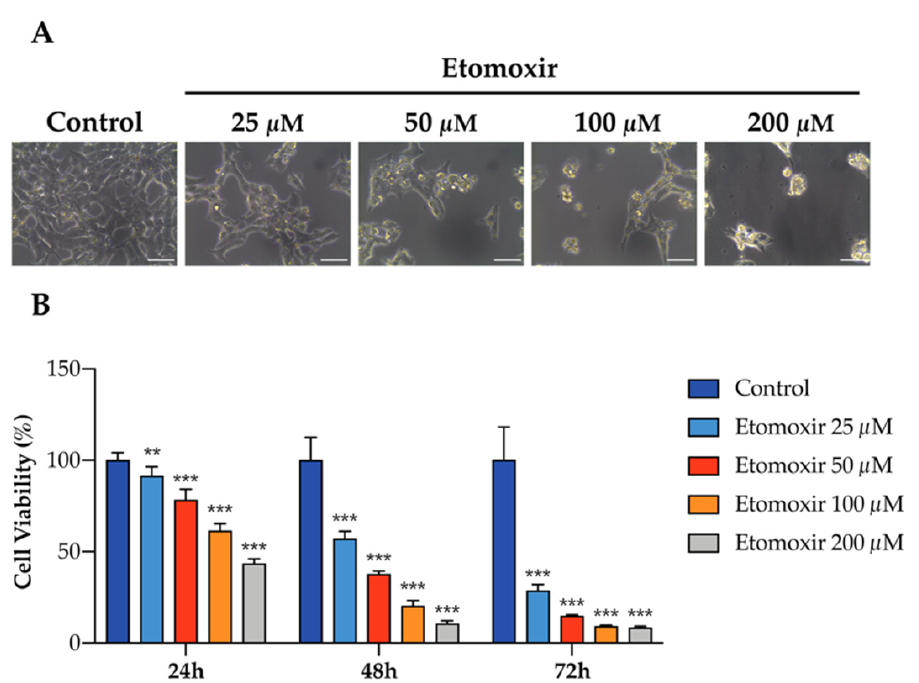
Figure 3. Inhibition of fatty acid oxidation induces cell death in human HAC15 cells. ( A ) Represen- tative images of the effects of etomoxir in HAC15 cells in 6-well plate for 72 h. Scale Bar: 50 µ m. ( B ) Cell viability in HAC15 cells treated with increasing concentration of etomoxir (25–200 µM) for 24 h, 48 h, and 72 h. Data are presented as mean ± s.d., One-way ANOVA; ** p < 0.01, *** p < 0.001.